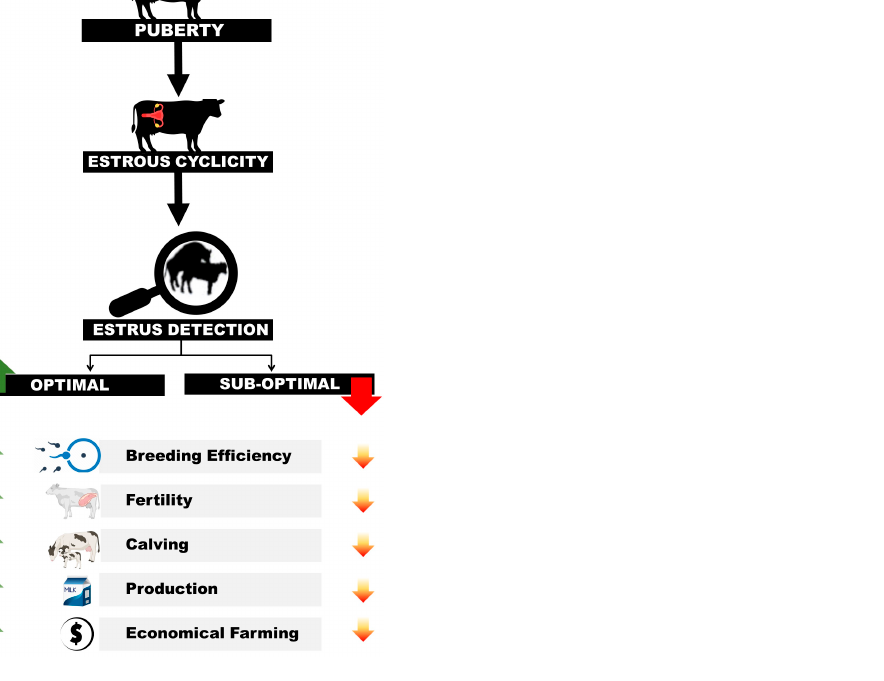
Figure 1. Illustrative diagram of the economic impact of optimal and suboptimal estrus detection in dairy animals.